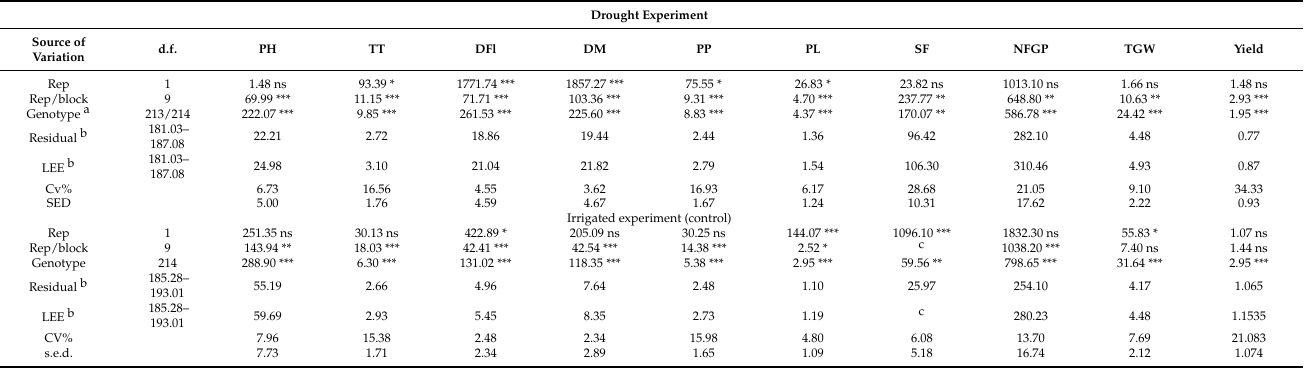
Table 2. Restricted Maximum Likelihood analysis for yield and other agronomic traits for field